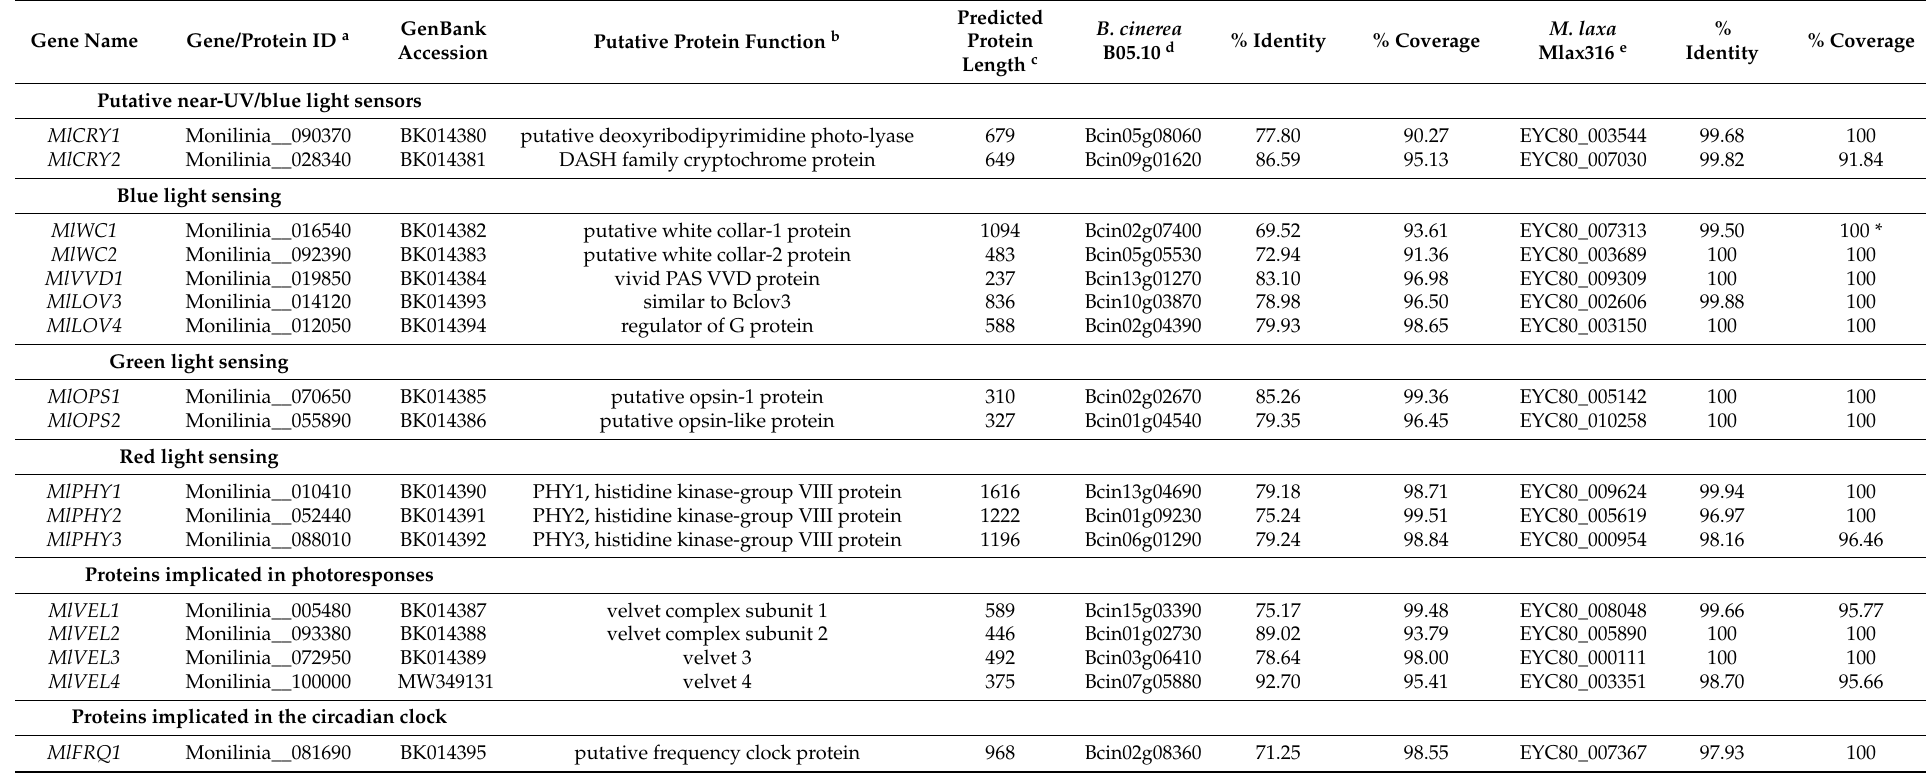
Table 1. Proteins implicated in photoresponses and potential photoreceptors of Monilinia laxa